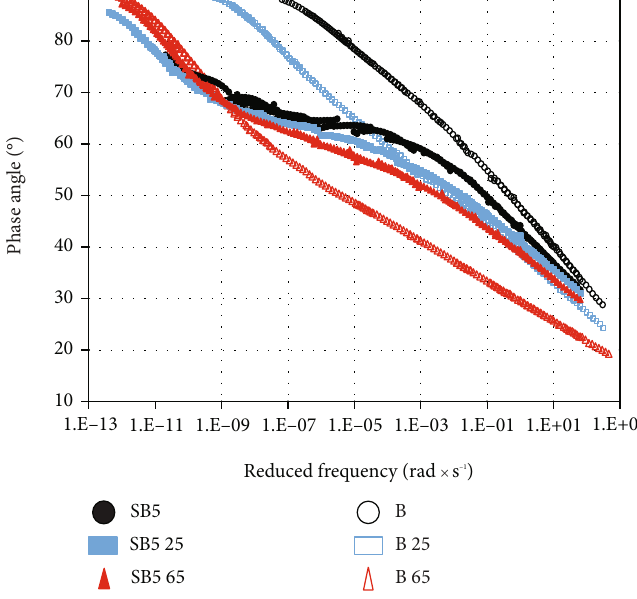
Figure 3: SB5 and B at di ff erent levels of